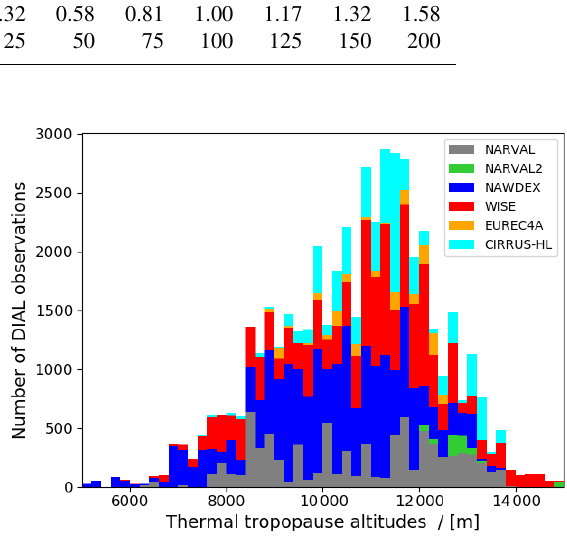
Figure 3. Histogram of the number of observations per thermal tropopause altitude bin (1000m) and per campaign (coloured